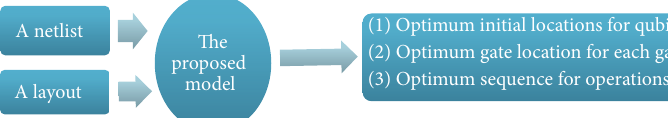
Figure 4: Inputs and outputs of the proposed model.